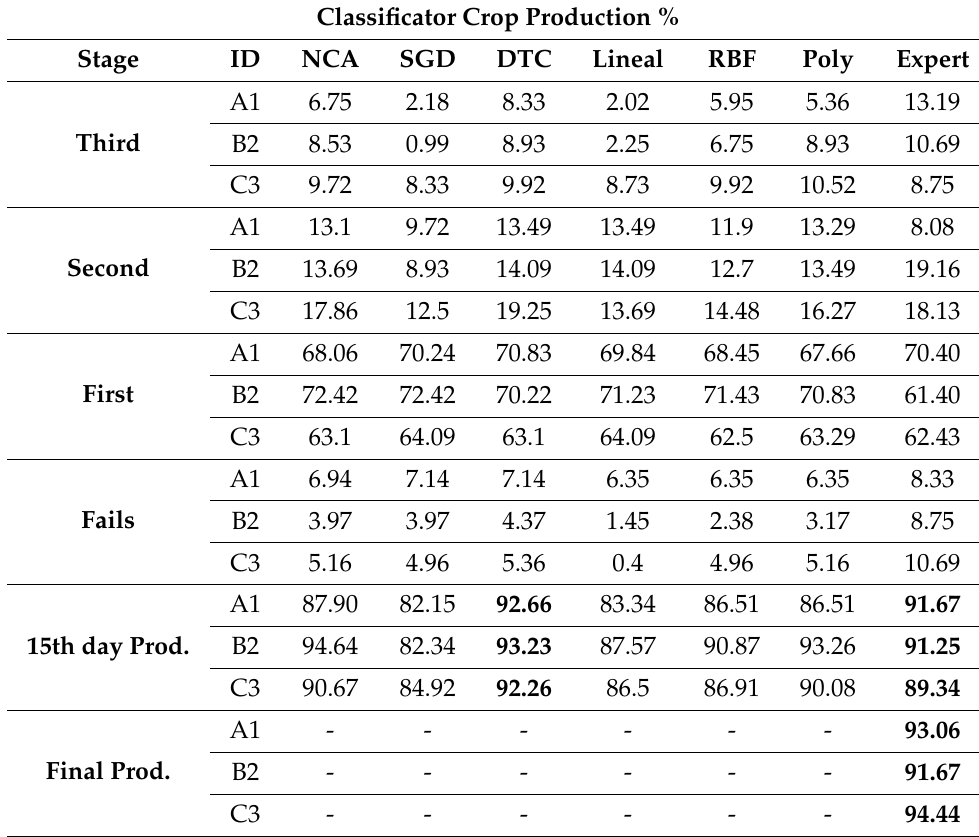
Table 3. Crop production accuracy by growth stage of each classifier against the expert’s crop production accuracy.